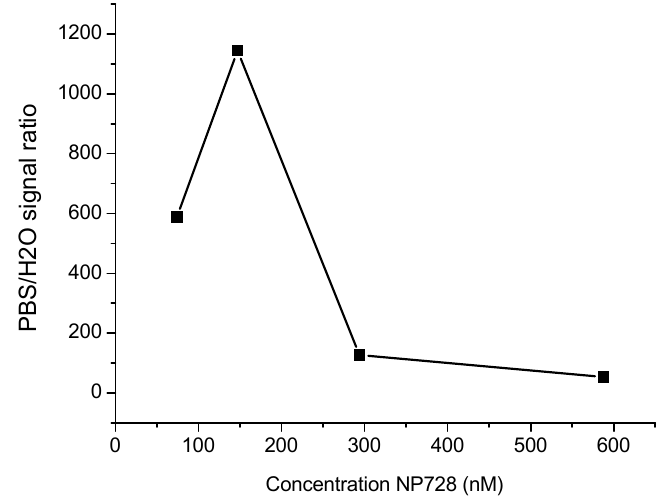
Figure 2. Long-lived fluorescence measured for NP728 in PBS and water at varying NP concentration. Incubation of NPs in PBS increases the long-lived fluorescence 1,000-fold compared to incubation in water. The signal-increase is NP-concentration